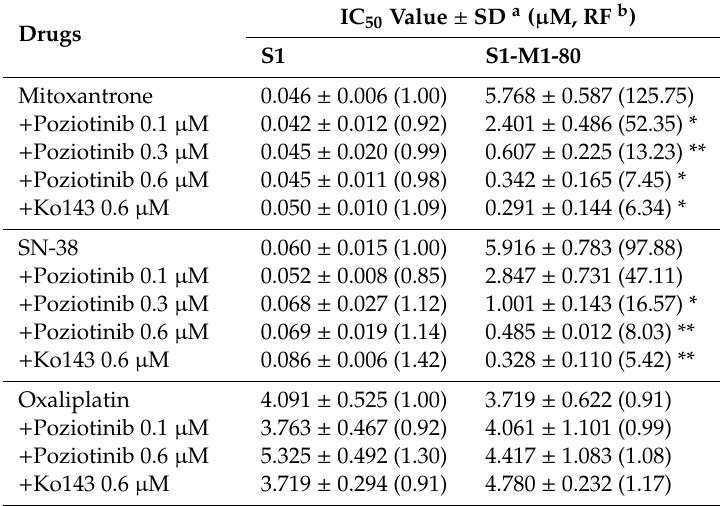
Table 1. The e ff ect of poziotinib and Ko143 on the e ffi cacy of mitoxantrone, SN-38 and oxaliplatin in colon cancer cells overexpressing the ABCG2